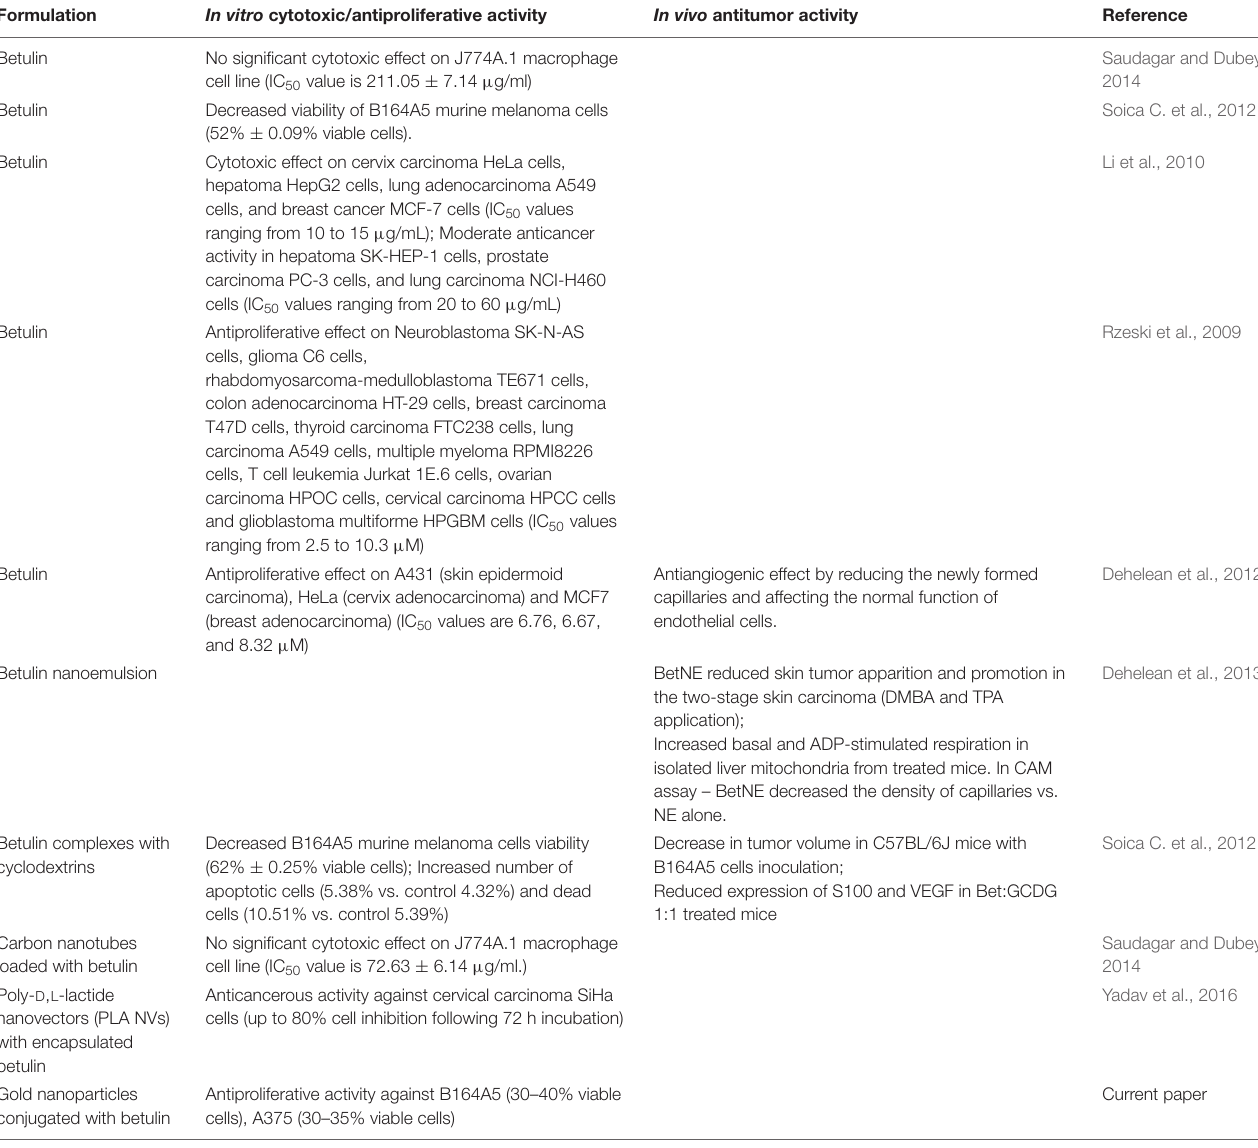
TABLE 4 | Biological activities of different betulin